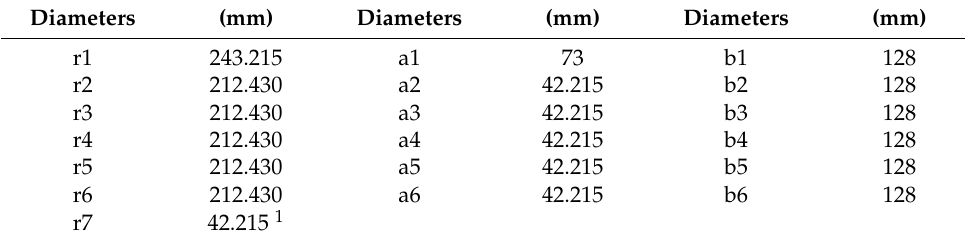
Table 1. Dimensions table of the robotic arm of Figure 2 and also Figure 3, Figure 4, respectively.